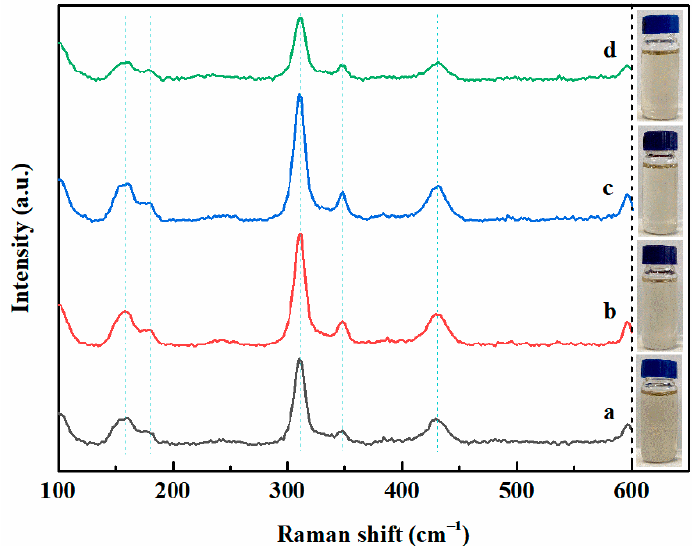
Figure 8. Raman spectra and photographs of the EMIC-AlCl 3 -MnCl 2 ionic liquids containing (a) no, and 6 mmol · L − 1 (b) 4-hydroxypyridine, (c) 4-picolinic acid, and (d) 4-cyanopyridine additives. Based on the double electrical layer’s theory, the schematic diagram of the mechanisms of 4-cyanopyridine in the EMIC-AlCl 3 -MnCl 2 ionic liquid is displayed in Figure 9. In